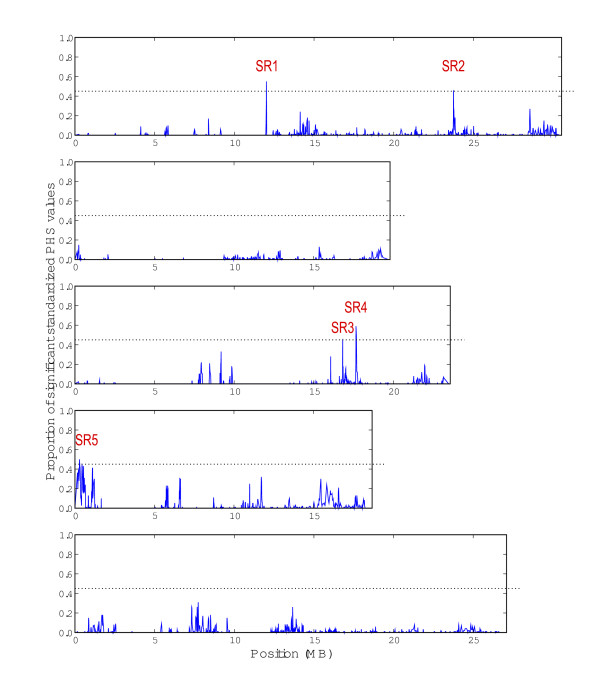
Map over all sweep candidates. The graph shows the density of significantly scoring SFPs measured by the proportion of significant SFPs in a sliding window (windows size of 1000 SFPs, offset between windows of 50 SFPs) across the genome. The dashed line represents the cut-off for the definition of sweep candidates. Sweep candidate regions (SR) are denoted in red.